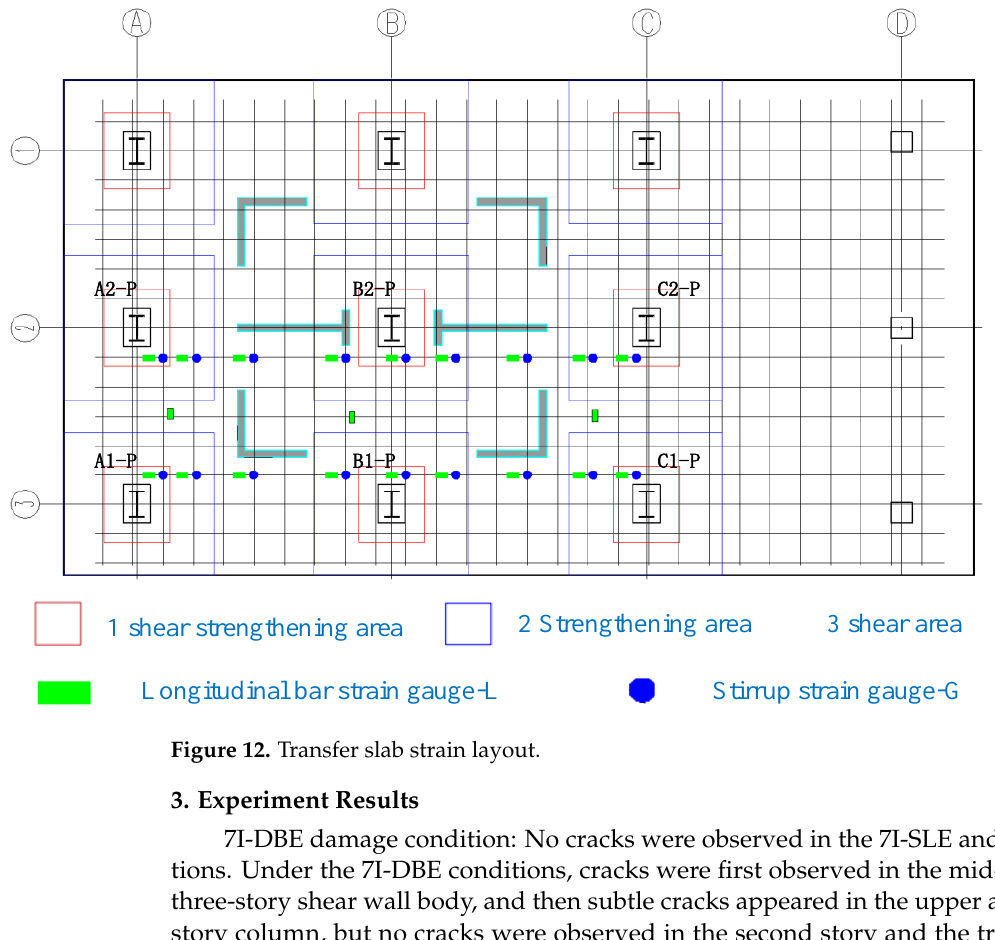
Figure 12. Transfer slab strain layout.